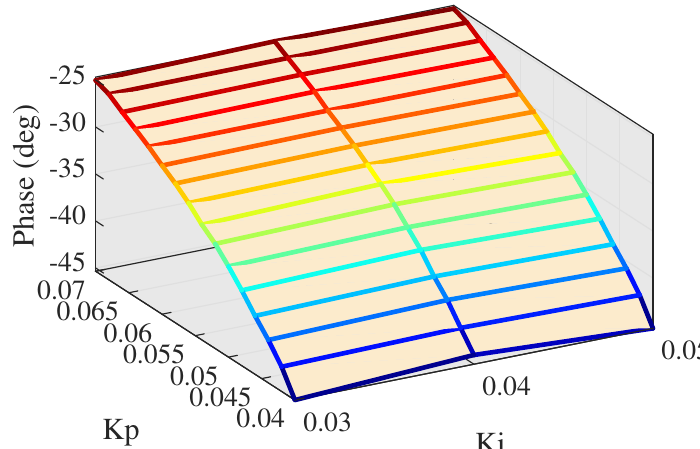
Figure 24. Phase lag at middle level